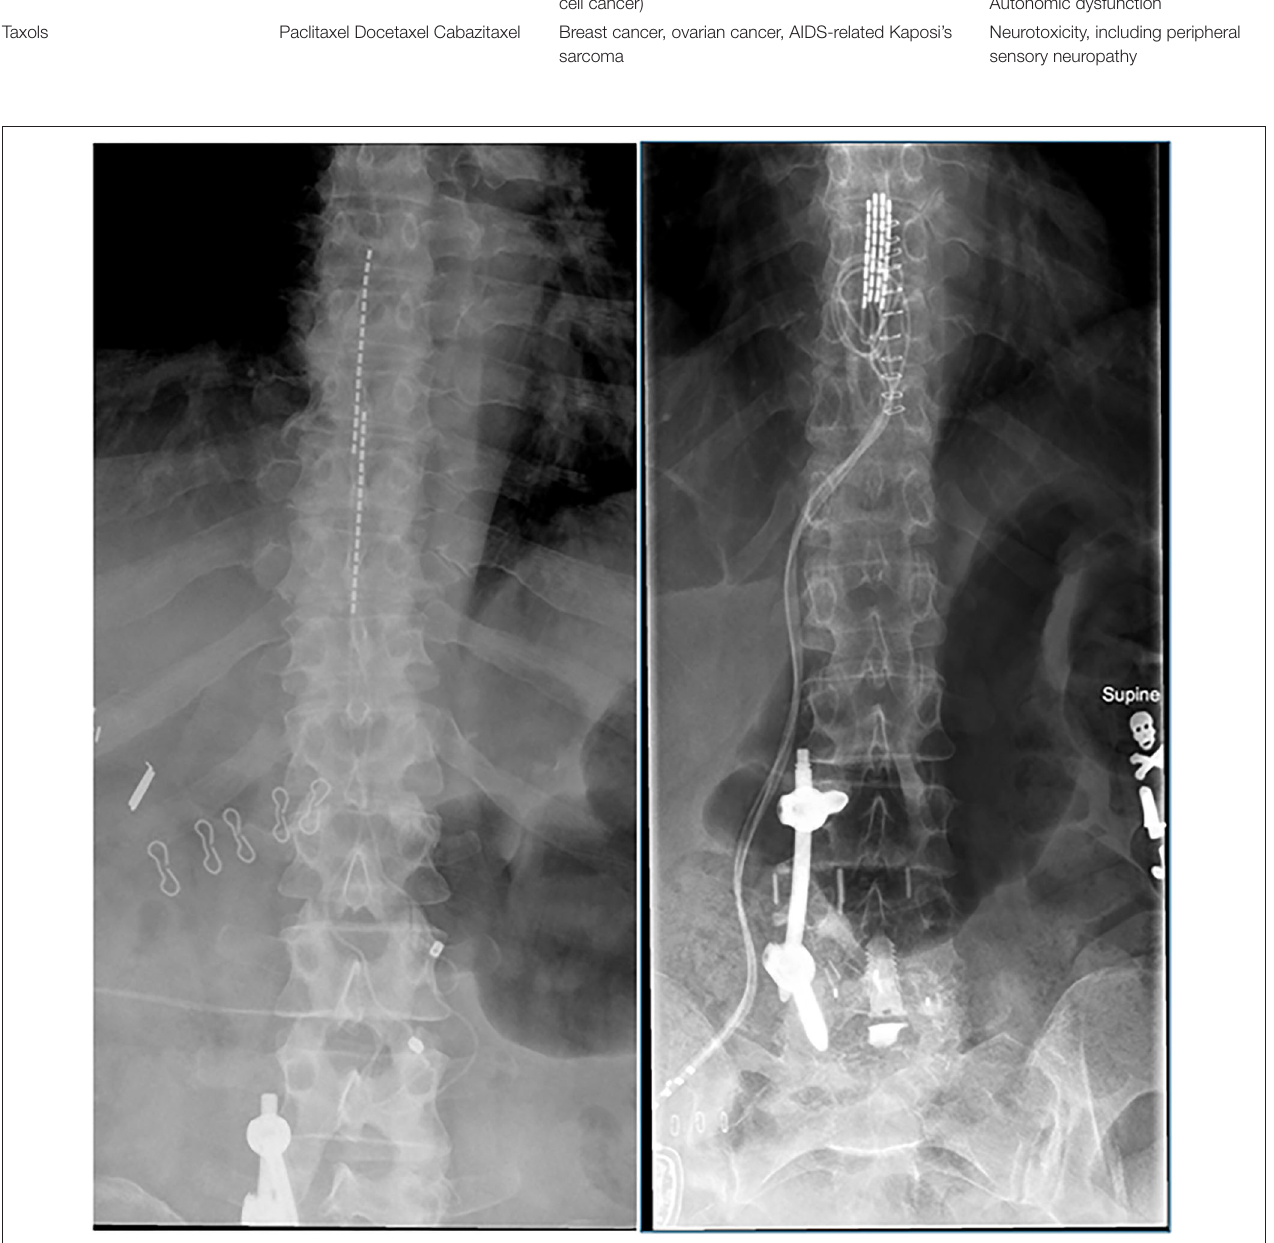
FIGURE 1 | Examples of percutaneous SCS leads (left) and paddle SCS leads (right) .